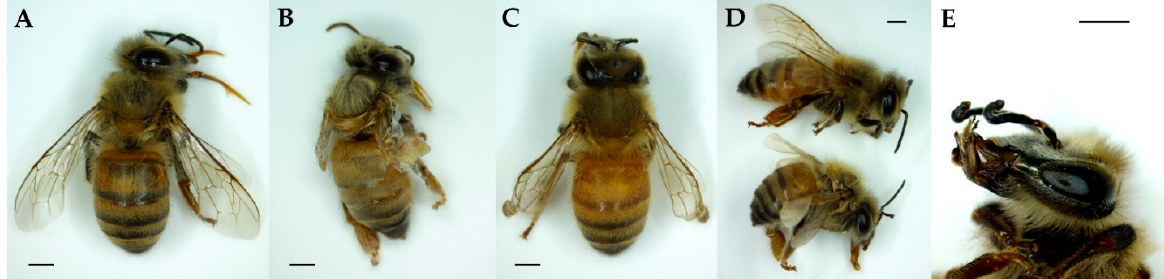
Figure 4. The observed symptoms of newly emerged adult bees. ( A ) Surviving normal (SN); ( B ) Deformed with short wings (DSW); ( C ) Deformed with tangled wings (DTW); ( D ) Normal (above) and abnormal abdomen shape (AAS) (below); ( E ) Deformed antennae (DA). Scale bar = 1 mm. Table 4. The overall percentage of observed symptoms of newly emerged adult bees. Each percentage in the following table is a calculated value of the ratio of the number of deformed bees to the total number of emerged bees. Observed Symptoms ¹